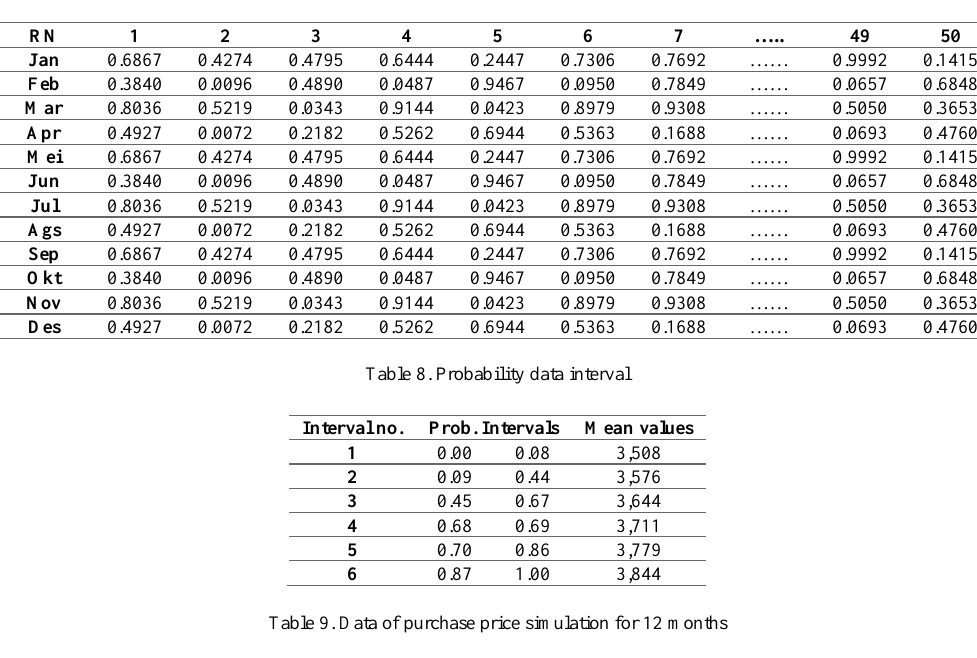
Table 7. Random number generated for Monte Carlo simulation